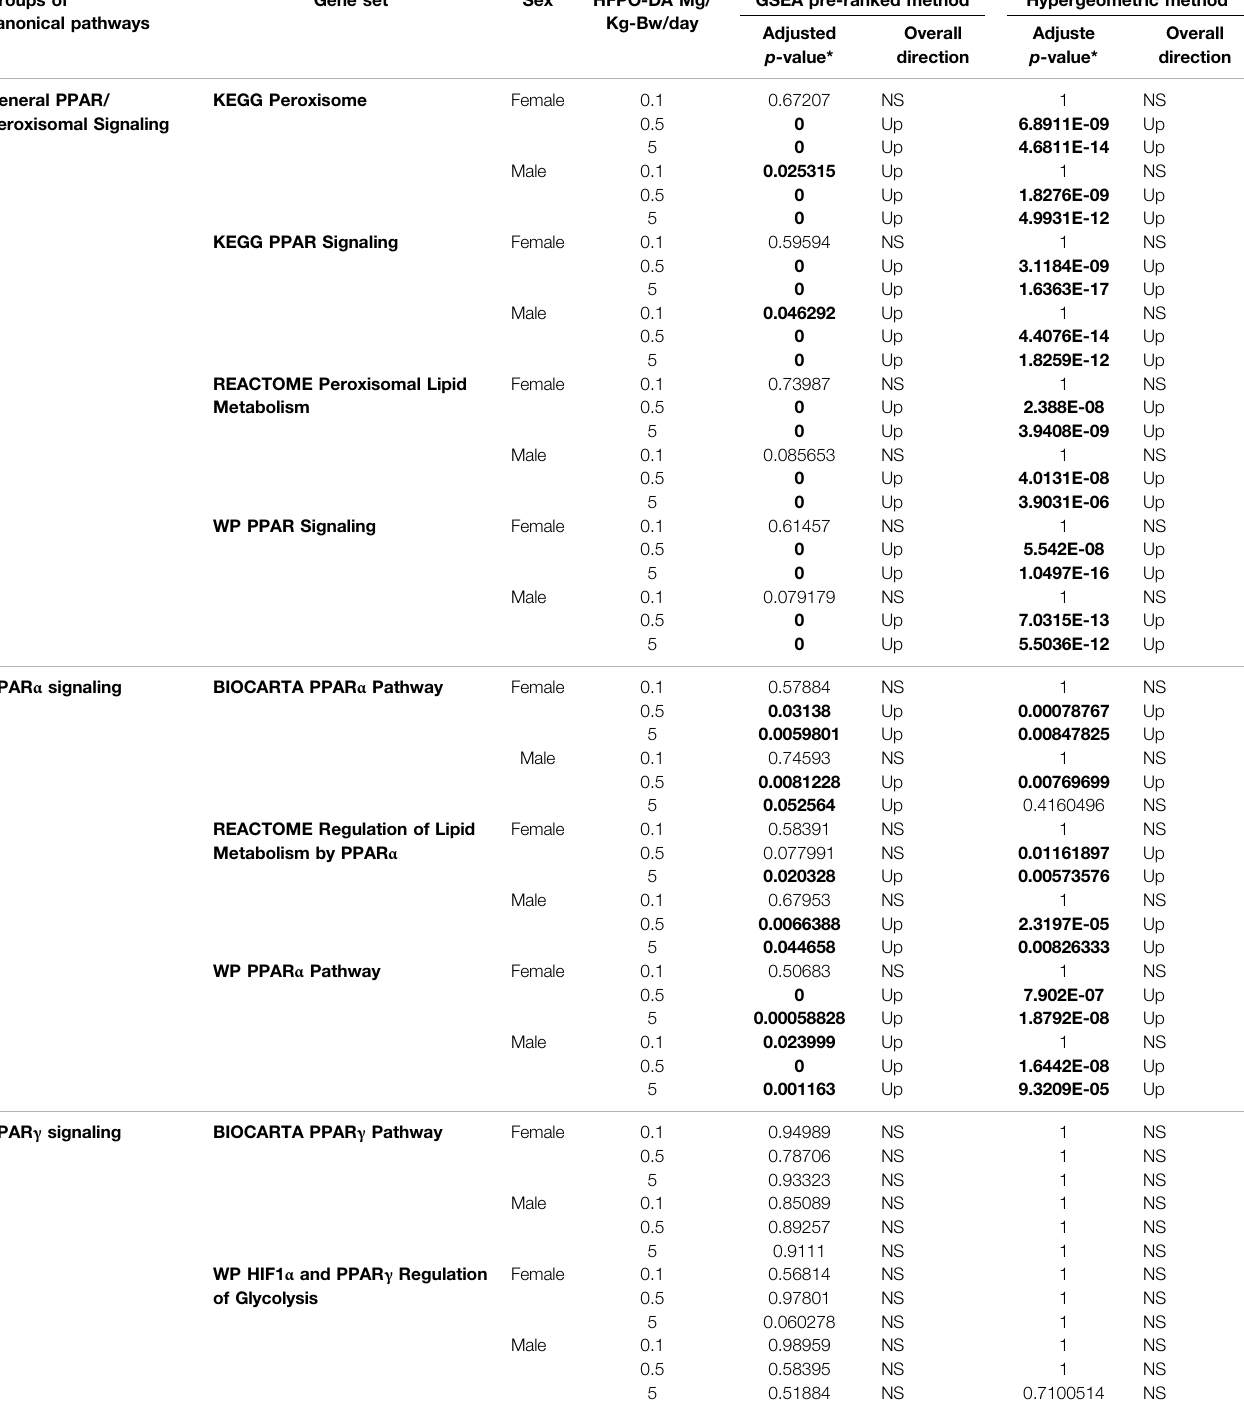
TABLE 1 | Comparison of enriched gene sets for general peroxisome/PPAR signaling and PPAR α -versus PPAR γ -speci fi c gene sets in HFPO-DA-exposed mice. Groups of Gene canonical pathways